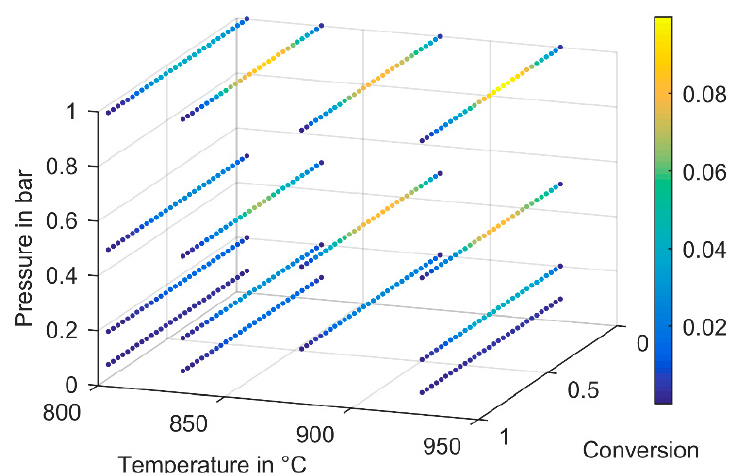
Figure 9. All measured data in conversion, temperature, and pressure (ctp) diagram.